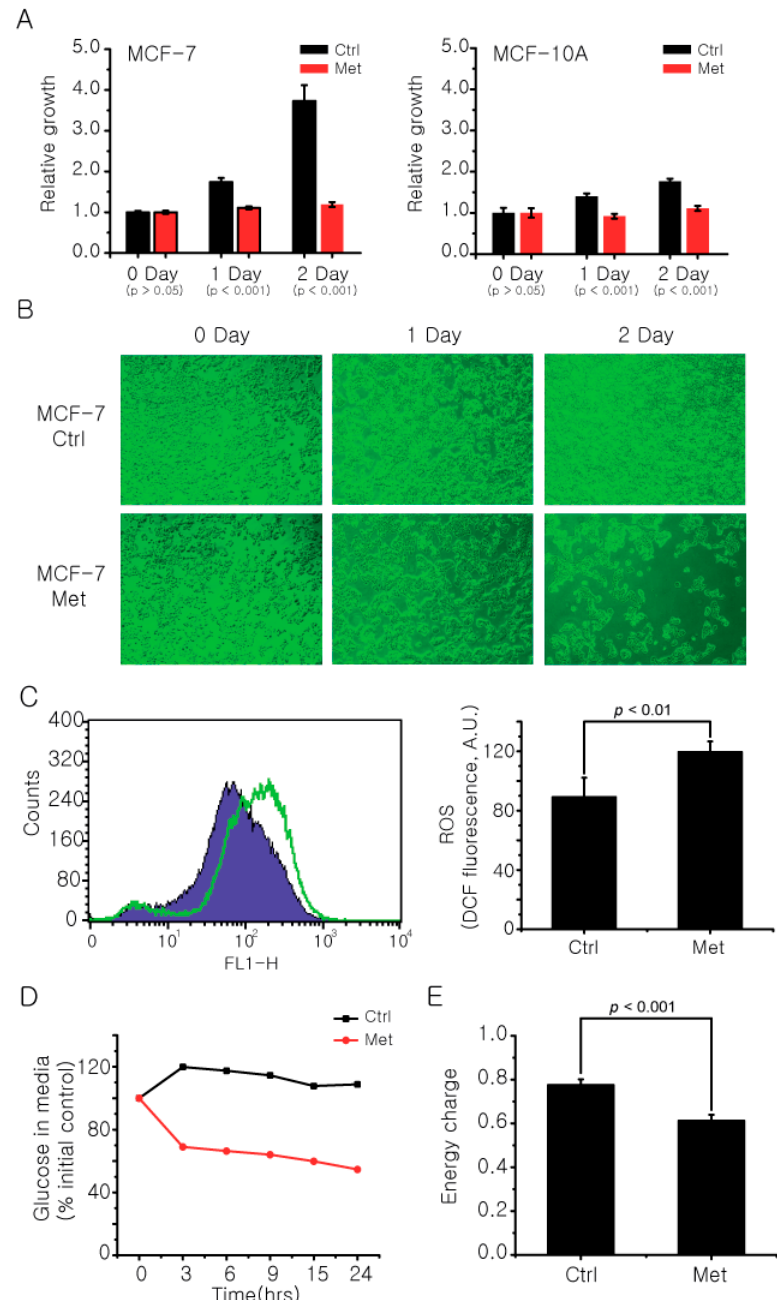
Figure 2. Metformin affects cancer cell growth and metabolic phenotypes. The final concentration of 20 mM metformin was treated to MCF-7 and MCF-10A cells for 2 days and the cell viability at each day was measured by a standard MTT assay ( A ) and microscope ( B ). ( C ) The change in ROS levels in MCF-7 cells after metformin treatment was measured using a fluorescent dye DCFH-DA. ( D ) The difference in glucose uptake by metformin treatment was compared by measuring glucose level in MCF-7 cell culture media using an NMR spectrometer. The relative amounts were normalized against the 0 h point. ( E ) The change in energy charge of MCF-7 cells after metformin treatment was calculated with absolute concentrations of AMP, ADP, and ATP measured with LC/MS using the following equation: ([ATP] + 0.5 [ADP])/([ATP] + [ADP] + [AMP]). Ctrl: control group; Met: Metformin treated group. The data are from three independent experiments. The error bars represent the standard deviation.